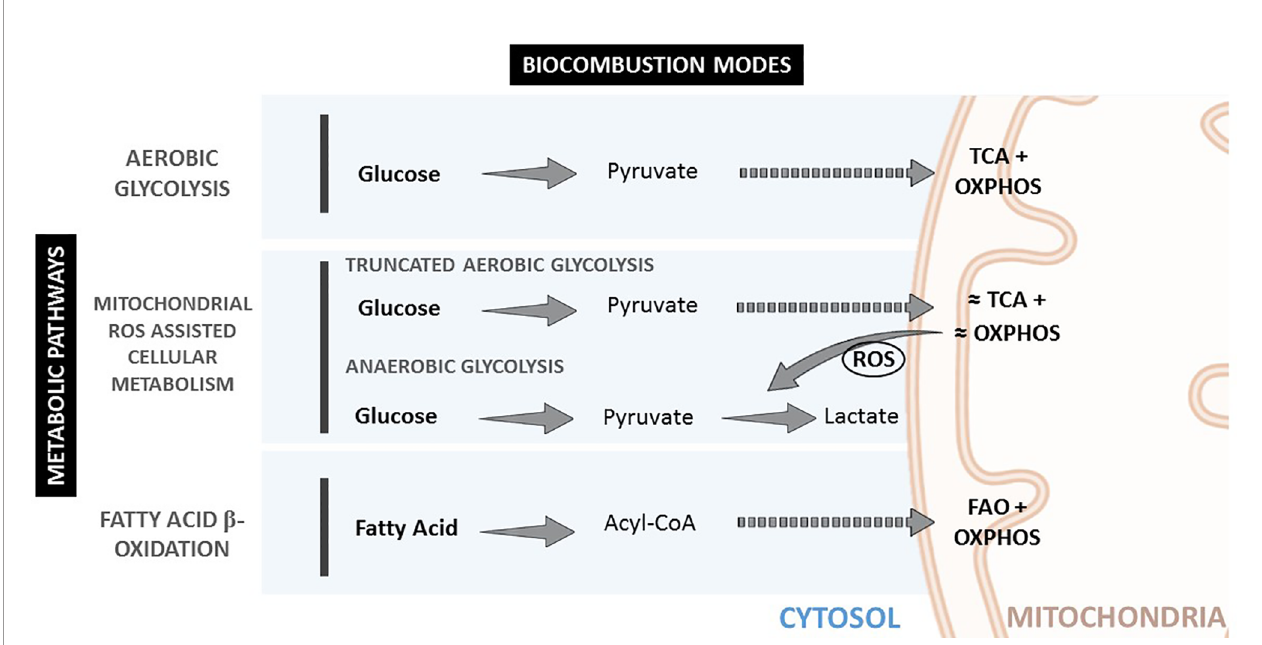
FIGURE 1 | Metabolic pathways and biocombustion modes inside the